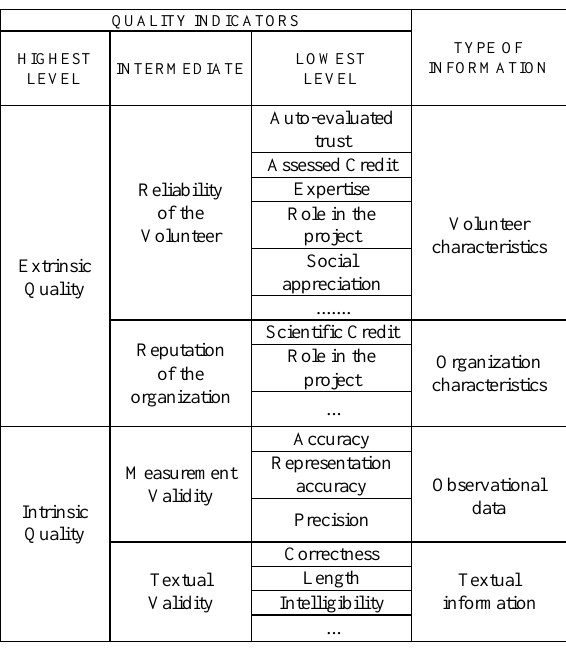
Table 1: hierarchy of quality indicators for different